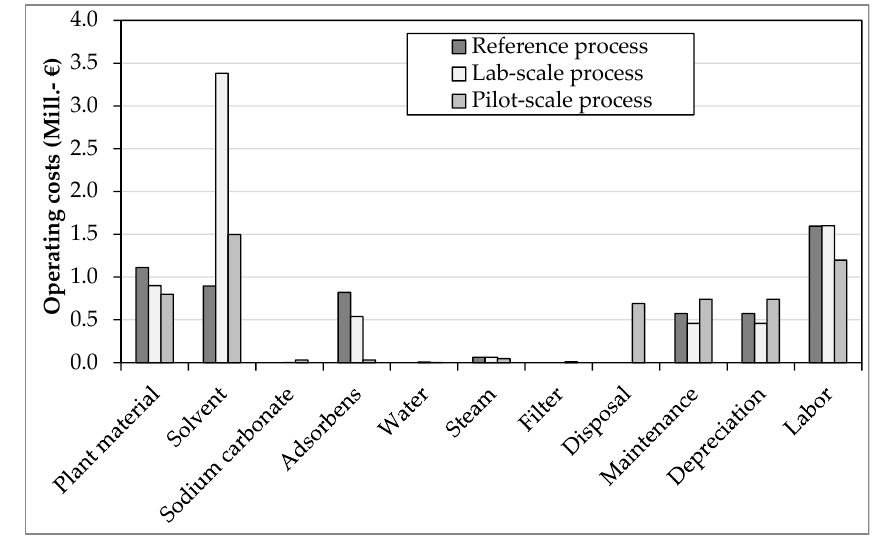
Figure 6. Summary of the operating costs.